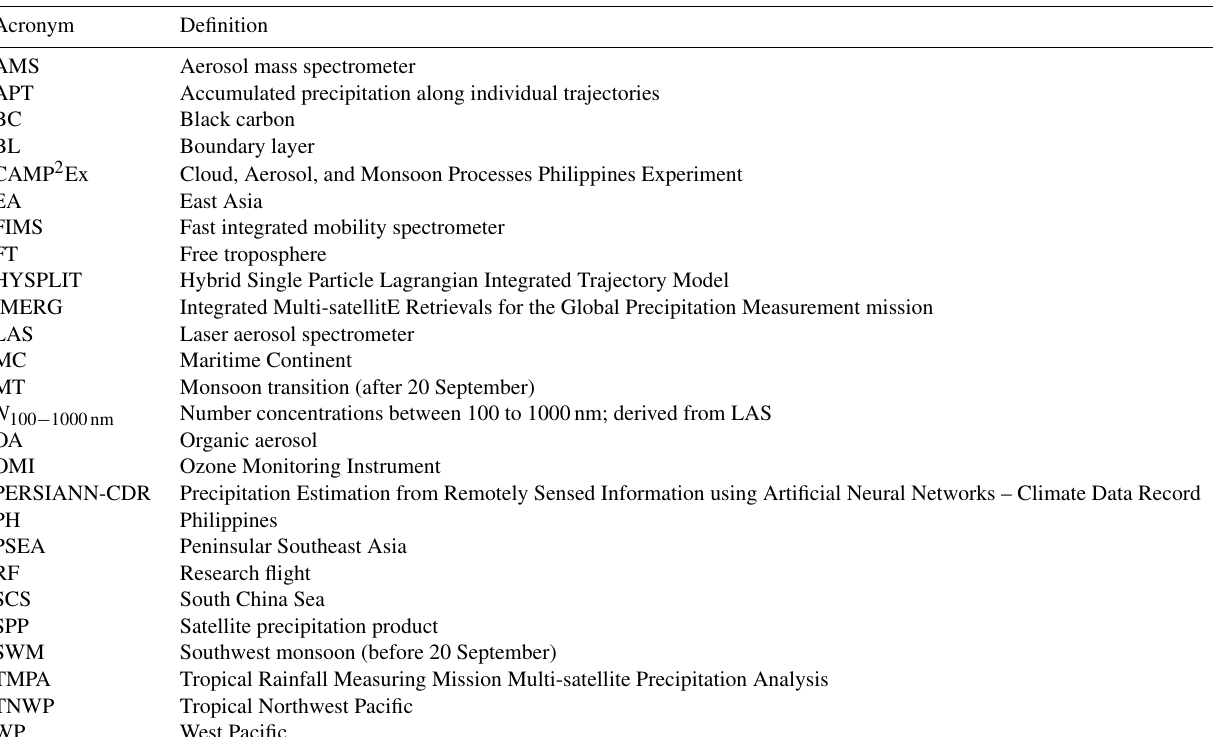
Table 1. Definitions of frequently used abbreviations in this work.